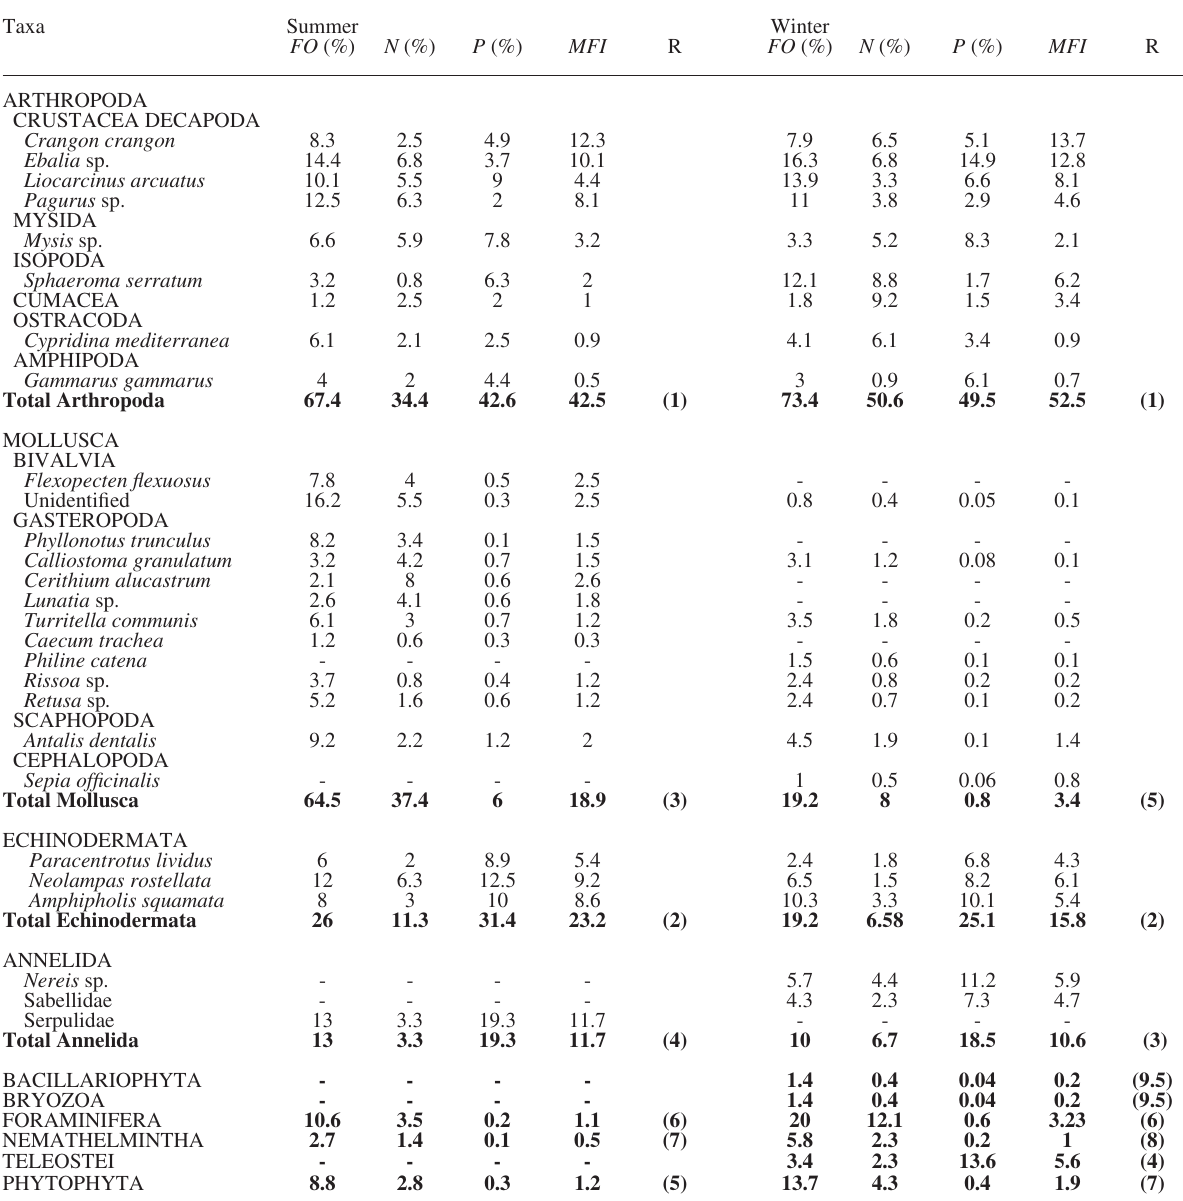
Table 11. – Prey identified in the stomach contents of P. acarne adults in relation to season. FO , frequency of occurrence; N , numerical percentage; P , point percentage; MFI , main food index; R, classification of prey. taxa summer